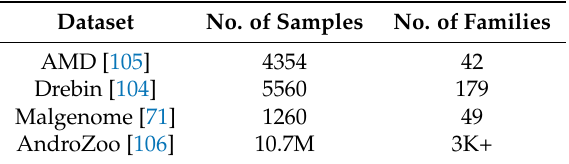
Table 4. Commonly used Datasets and their